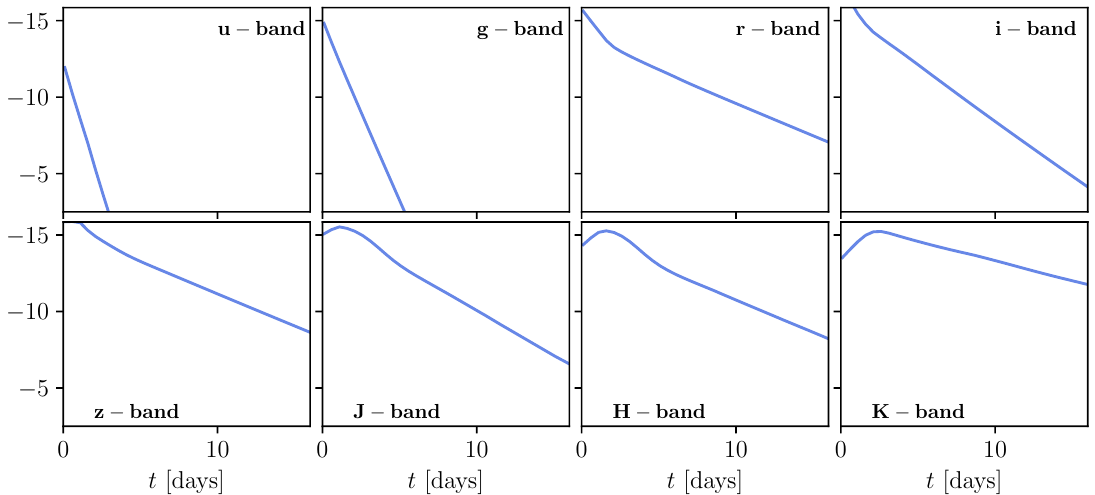
Figure 8. Estimated absolute magnitude of the kilonova in different frequency band using the methods outlined in References